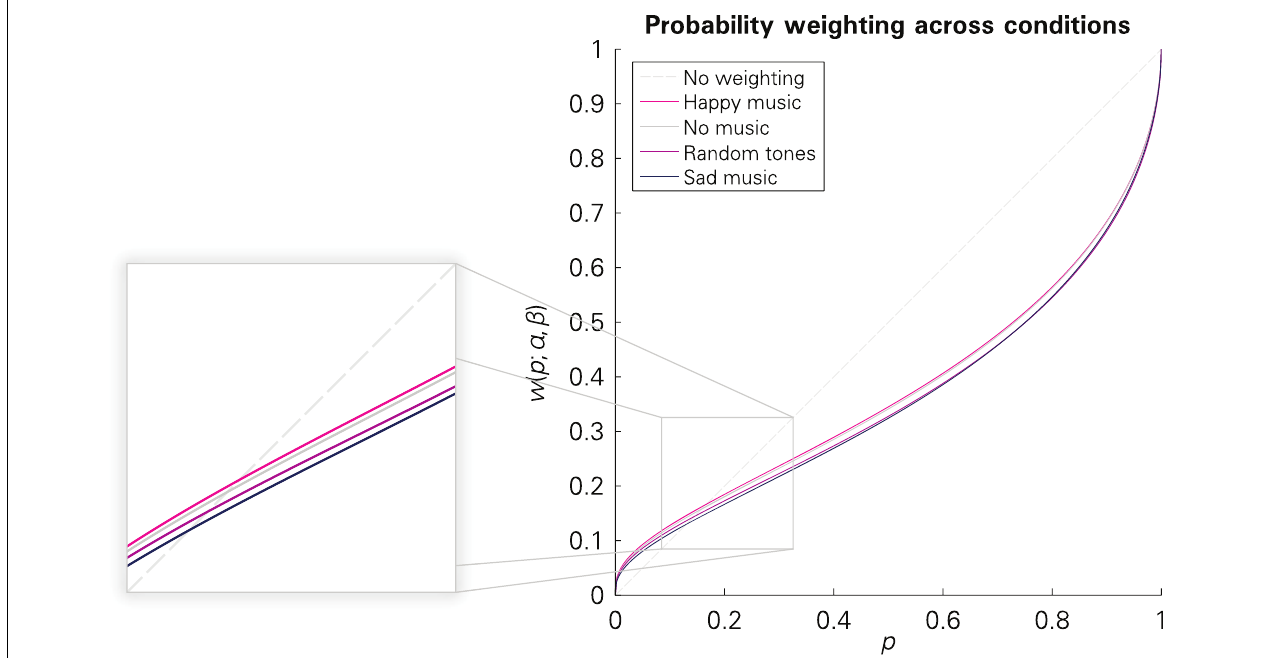
FIGURE 4 | Probability weighting functions in the four conditions based on the parameter estimates for the structural regression model reported in Table